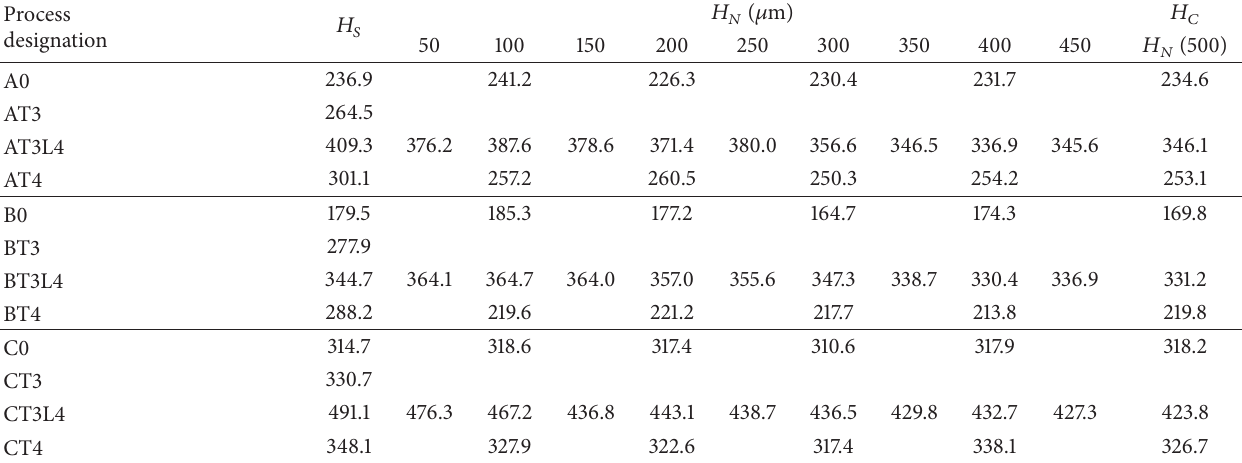
Table 6: 𝐻 𝑆 , 𝐻 𝑁 , and 𝐻 𝐵 for typical specimens (Vickers hardness measured at the load of 50 gw).